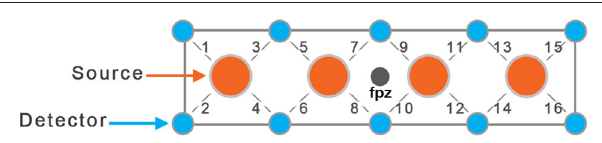
FIGURE 1 | Schematic of fNIRS sensor with four sources and 10 detectors (16 source-detector